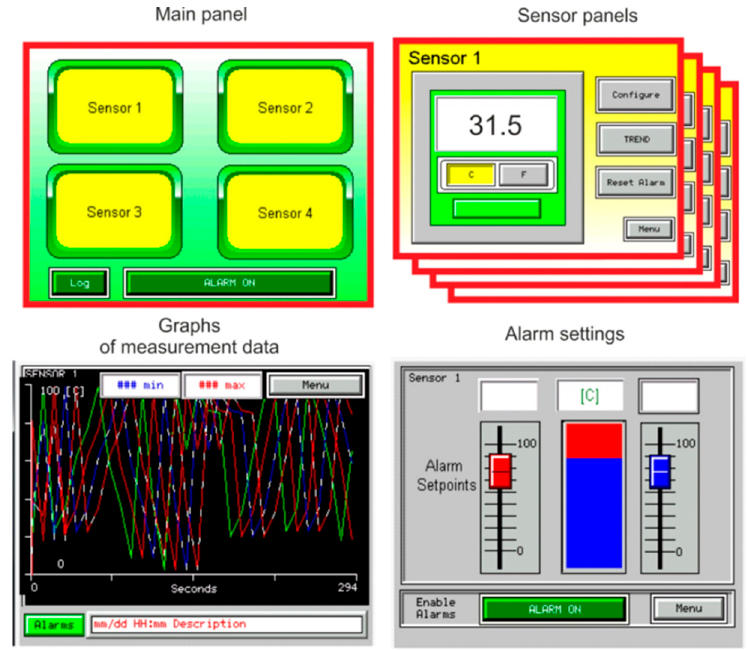
Figure 2. The view of the programmed PMD touch screen.